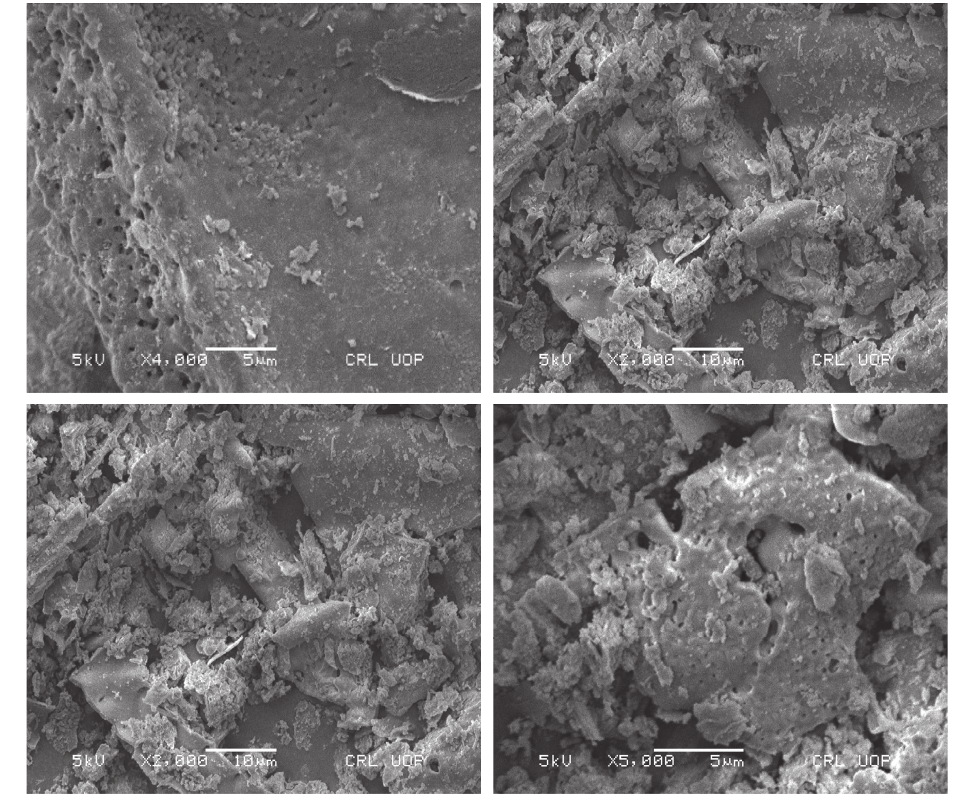
Figure 3: SEM images of SCBA at different magnifications. Table 4: Mix Proportions of the concrete